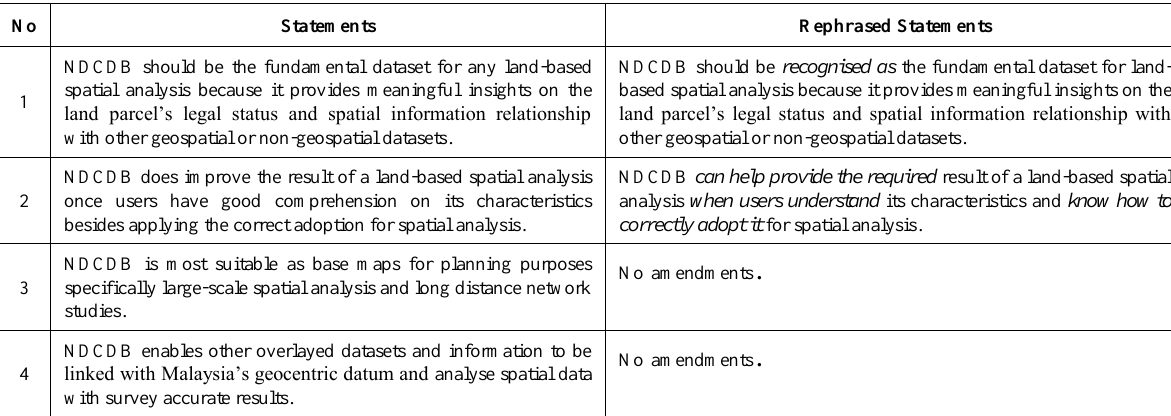
Table 7: Round 2 statements on NDCDB‘s significant role in land-based